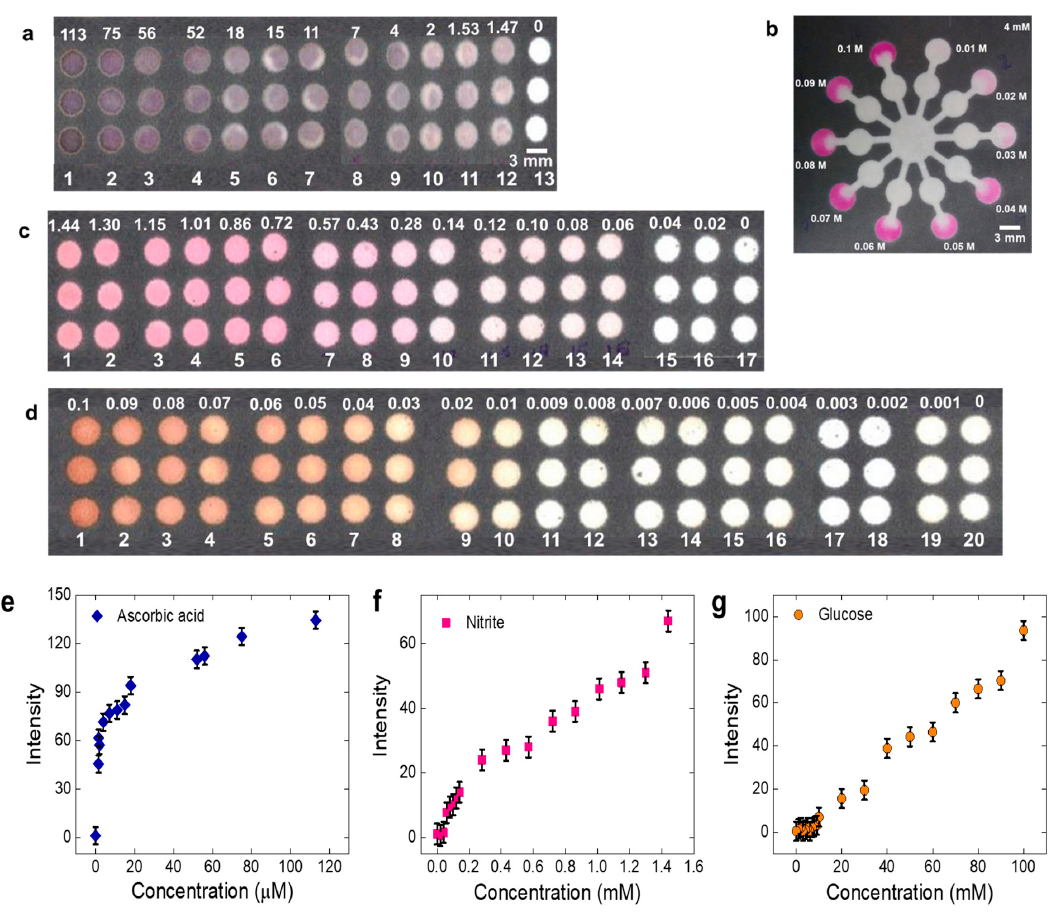
Figure 3. Demonstration of titration on paper microfluidics. ( a ) Ascorbic acid (concentrations are in µM); ( b ) citric acid; ( c ) nitrite (concentrations are in mM); ( d ) glucose (concentrations are in M); ( e ) Intensity Profile of a; ( f ) Intensity Profile of c; ( g ) Intensity Profile of d. (Scale bar: 3 mm). Table 1. Summary of the concentration of common analytes present in beverages.